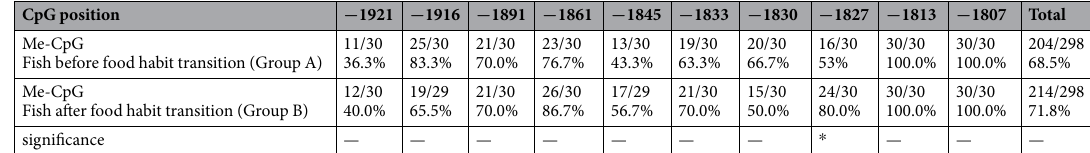
— — — — — — * — — — Table 4. Methylation status of each CpG in CpG island 1 of the T1R1 gene in grass carp before or after the food habit transition. * P < 0.05 — P > 0.05.